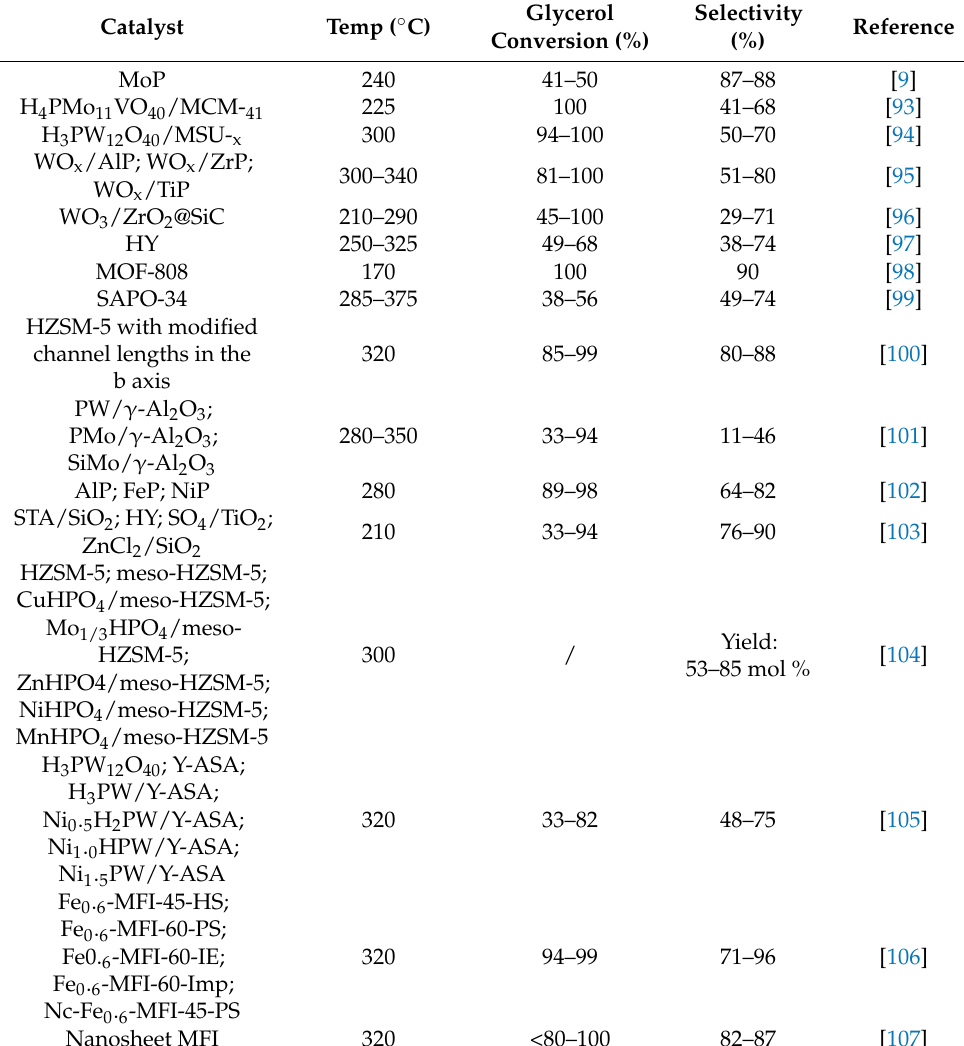
Figure 7. Two reaction pathways for acrolein preparation. Table 4. A summary of recent studies on catalytic dehydration of glycerol to produce acrolein.